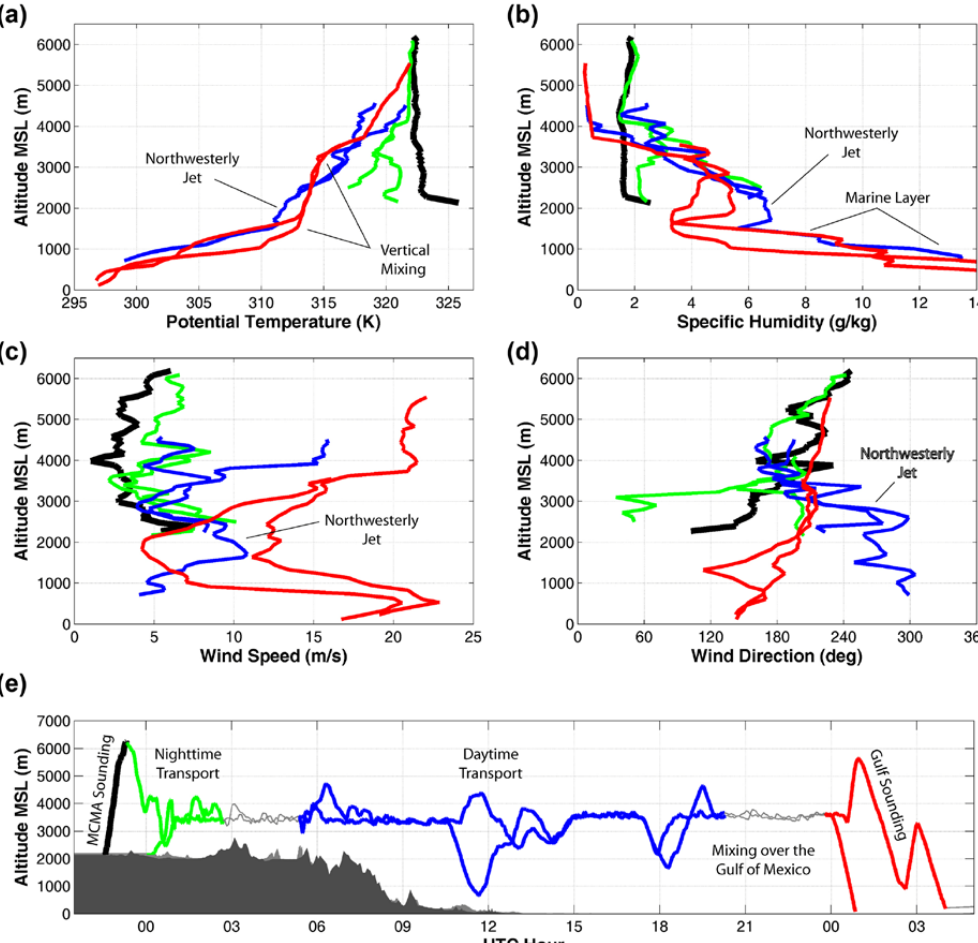
Fig. 11. Evolving profiles of potential temperature (a) , specific humidity (b) , wind speed (c) , and wind direction (d) averaged for the four stages of transport (e) observed on 18–19 March: uniform MCMA air leaving the basin (black), nighttime transport over the Sierra Madre Oriental (green), daytime transport over the Coastal Plain and Gulf of Mexico (blue), and mixing over the Gulf of Mexico (red).